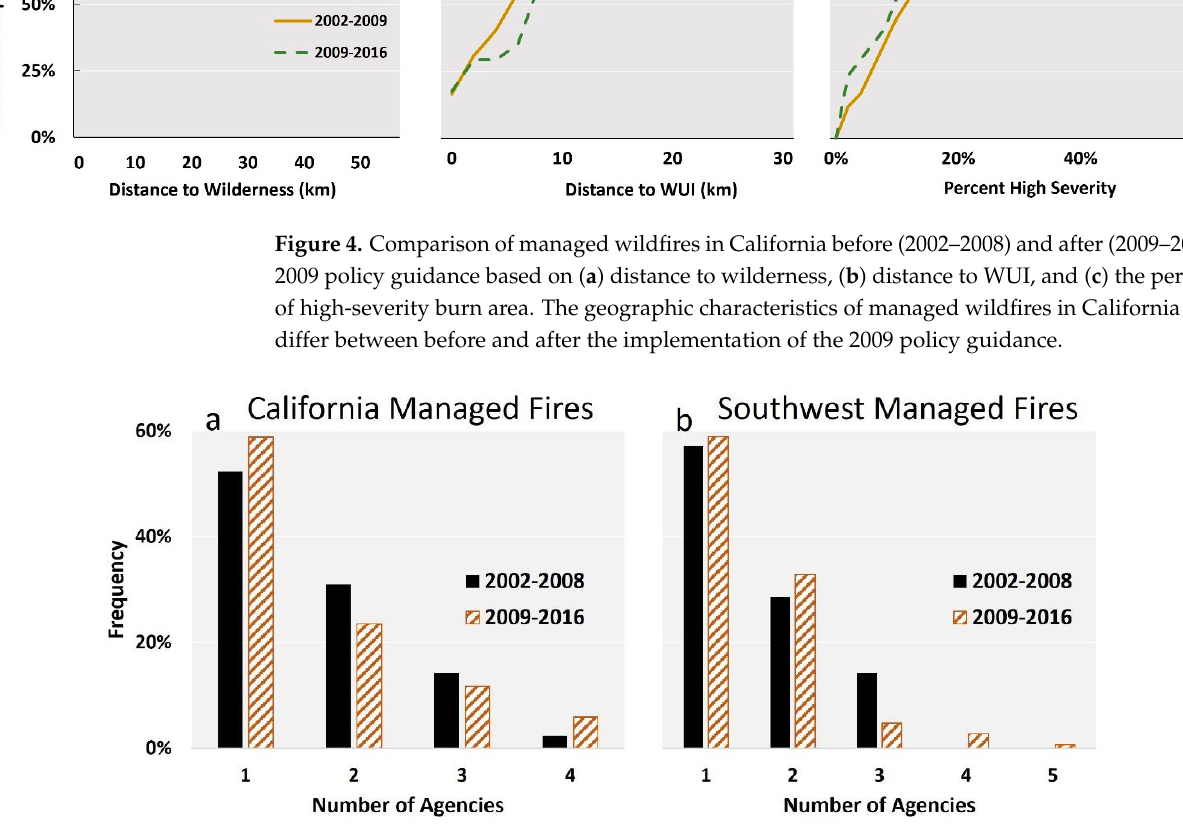
Figure 5. Comparisons of the number of land management agencies involved per managed wildfire before and after the introduction of the 2009 policy guidance in ( a ) California and ( b ) the Southwest. The number of agencies per managed wildfire in California and the Southwest did not change after the implementation of the 2009 policy